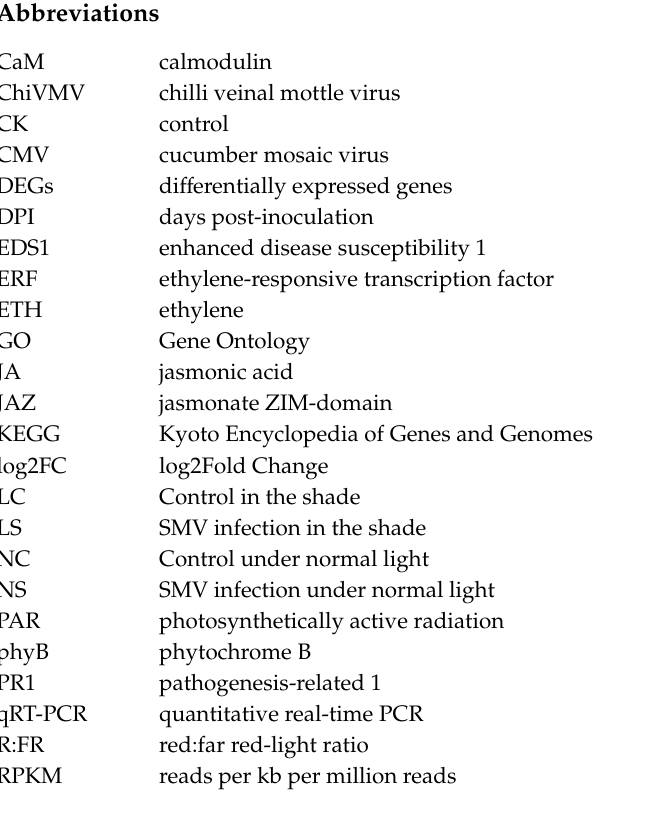
Figure S1. Plant pathogen interaction pathway map between NC vs NS. Figure S2. Plant pathogen interaction pathway map between LC vs LS. Figure S3. Plant defense hormone signal pathway map between NC vs NS. Figure S4. Plant defense hormone signal pathway map between LC vs LS. Table S1. Primers used for qRT-PCR validation. Table S2. Statistics of raw data. Table S3. Statistics of clean reads. Table S4. Statistics of RNA-Seq map. Table S5. Di ff erentially expressed genes involved in plant-pathogen interaction (ko04626) pathway between NC and NS. Table S6. Di ff erentially expressed genes involved in plant-pathogen interaction (ko04626) pathway between LC and